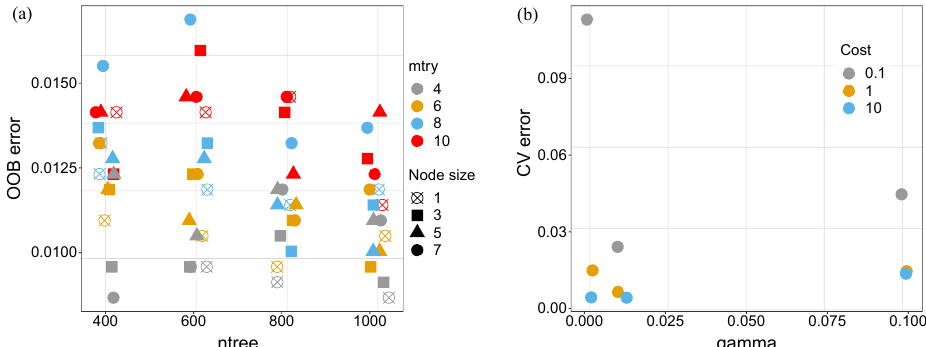
Figure 7. Results of the calibration process. ( a ) RF model. The mean of the OOB error for all classes is plotted as a function of the number of trees ( ntree ), nodesize and the mtry parameter. ( b ) SVM model results for 5-folds cross validation.